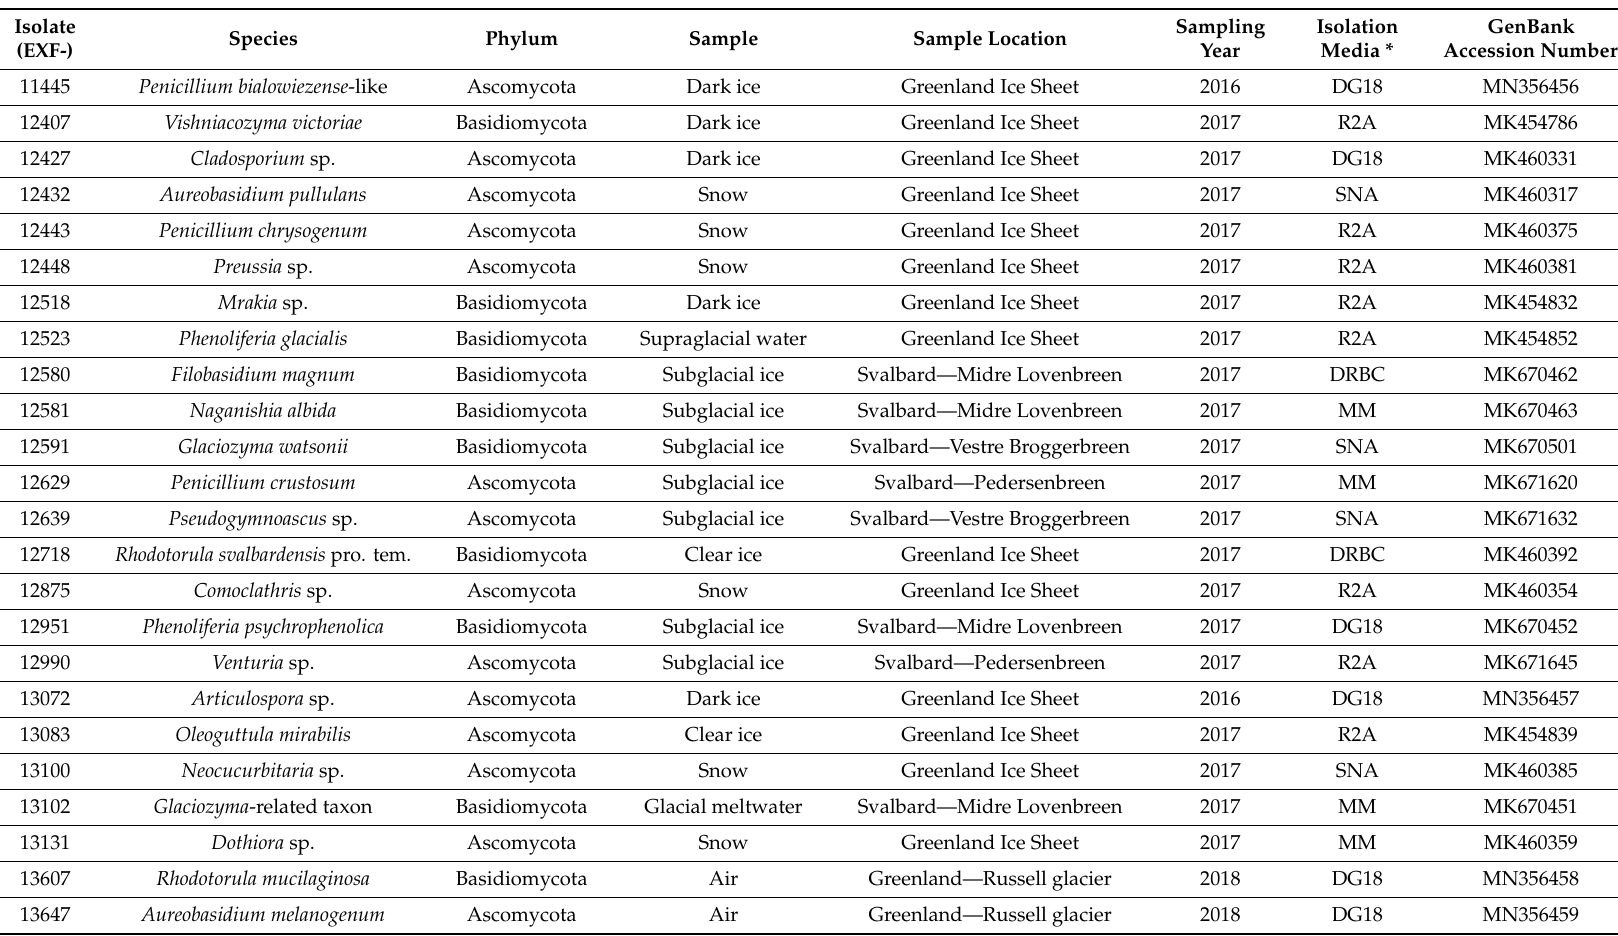
Table 2. List of the selected fungal species used in this study, EXF collection number, sample type, sampling location and year, isolation media, and GenBank reference of the deposited sequence used for